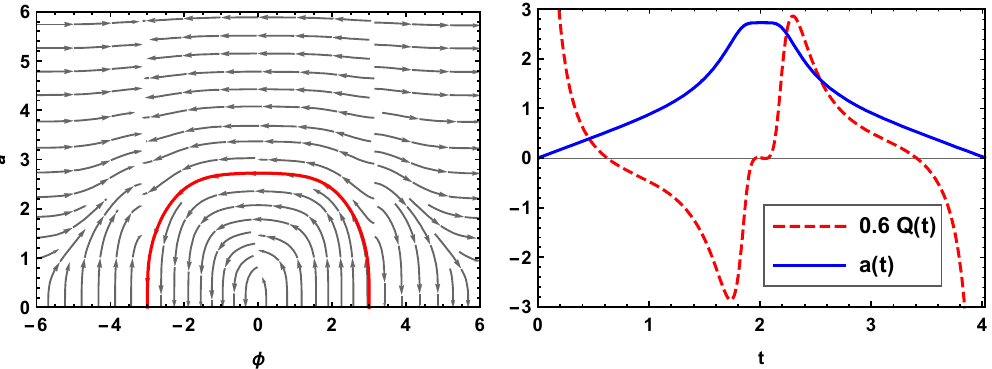
Figure 5. The phase portrait of system (40) is shown on the left-hand side, with V 0 = ω = k = 1, and the red line represents the solution for which φ ( 0 ) = 3 and a ( 0 ) = 0.001, as an example. On the right-hand side, we see the behavior of the scale factor (thick line) and the quantum potential (41) (dashed line), both being evaluated for the particular solution highlighted in the phase